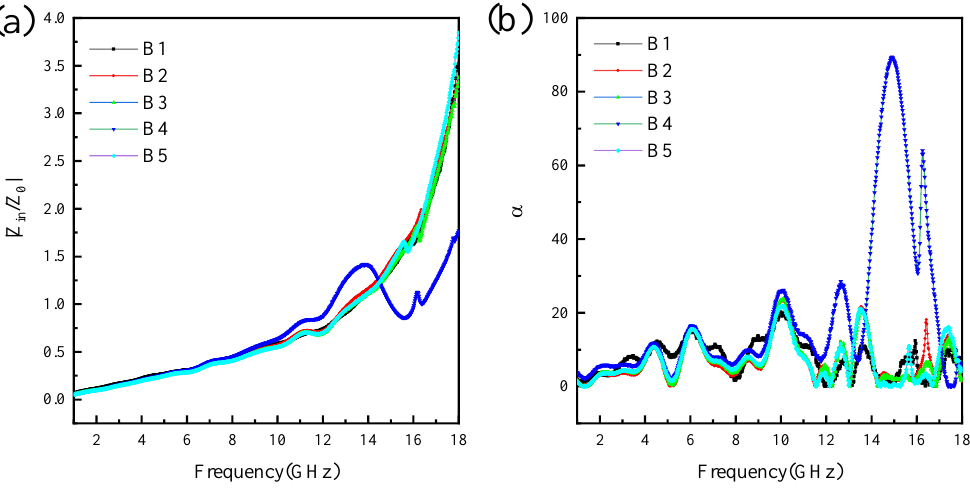
Figure 10. Impedance matching profiles ( a ) and attenuation constants ( b ) of samples. Based on the above analysis, the possible attenuation mechanisms of EM waves for FeAl 2 O 4 ferrite doped with 10wt% RGO/Cu composite powders are described in Figure 11. The superior absorption performance can be determined by the synergetic effect of various factors [2]. Firstly, a lower impedance matching value is conducive to electromag- netic waves entering the absorber, and the complex surface of the RGO/Cu composite powders can provide more reflection and scattering. Secondly, FeAl 2 O 4 ferrite with dou- ble complex characteristics evenly dispersed in paraffin can induce natural resonance and exchange resonance. The defects and residual oxygen-containing groups in RGO can not only improve the impedance matching performance of the material but also produce de- fect polarization relaxation. Electromagnetic dipole polarization relaxation with oxygen- containing functional groups effectively improves the wave-absorbing performance of the material. Moreover, the interfaces such as RGO/Cu, FeAl 2 O 4 / RGO/Cu, FeAl 2 O 4 /Paraffin, and RGO/Cu /Paraffin could induce abundant interfacial polarization [39]. Based on the above advantages, FeAl 2 O 4 /Cu/RGO composite material is expected to become an ideal electromagnetic-wave-absorbing material.